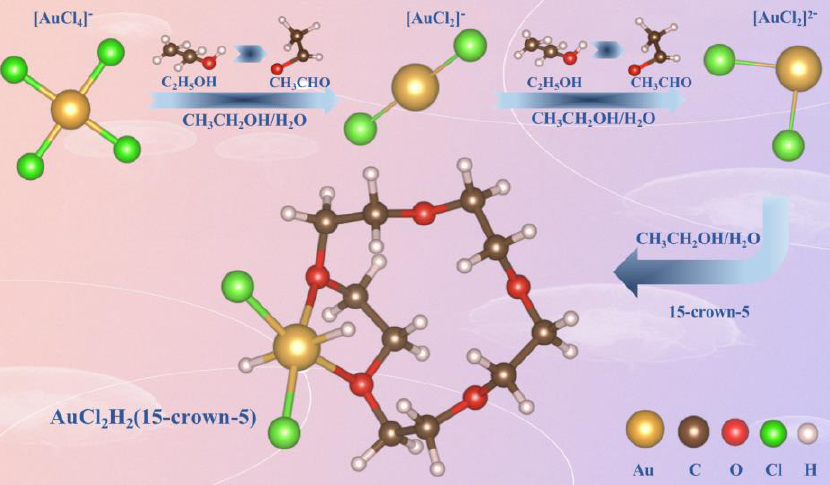
Figure 5. Synthesis procedures of Au 1 @15-crown-5.